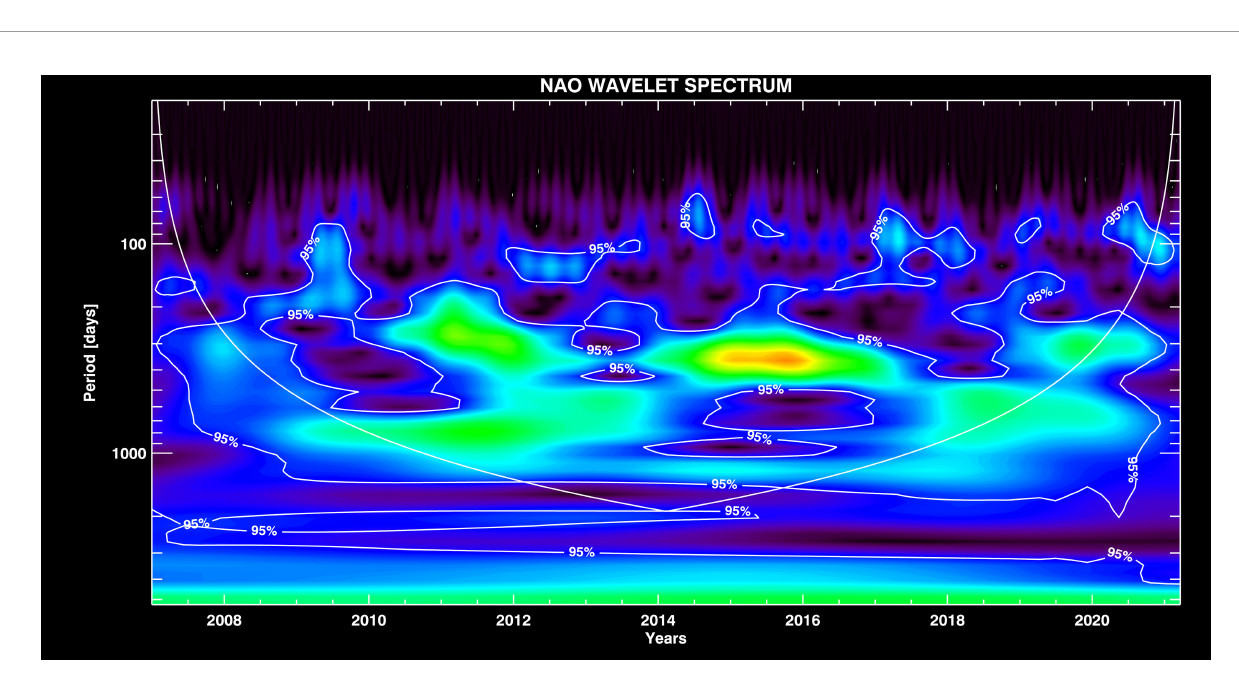
were fi ltered out by using 1 × BP 350 - 380 days. The very narrow band window is used in order to extract the unmodi fi ed seasonal components (which does not represent the full signal). The obtained correlation results are depicted in Table 1 and